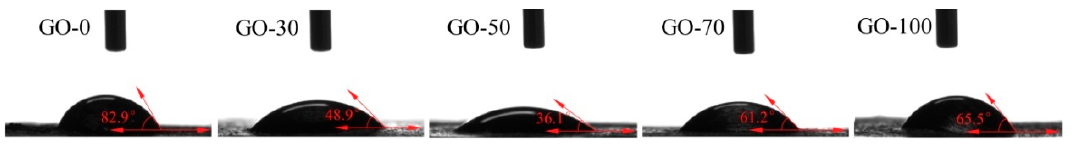
Figure 2 . Contact angle of graphite oxide samples prepared at different reaction temperatures.